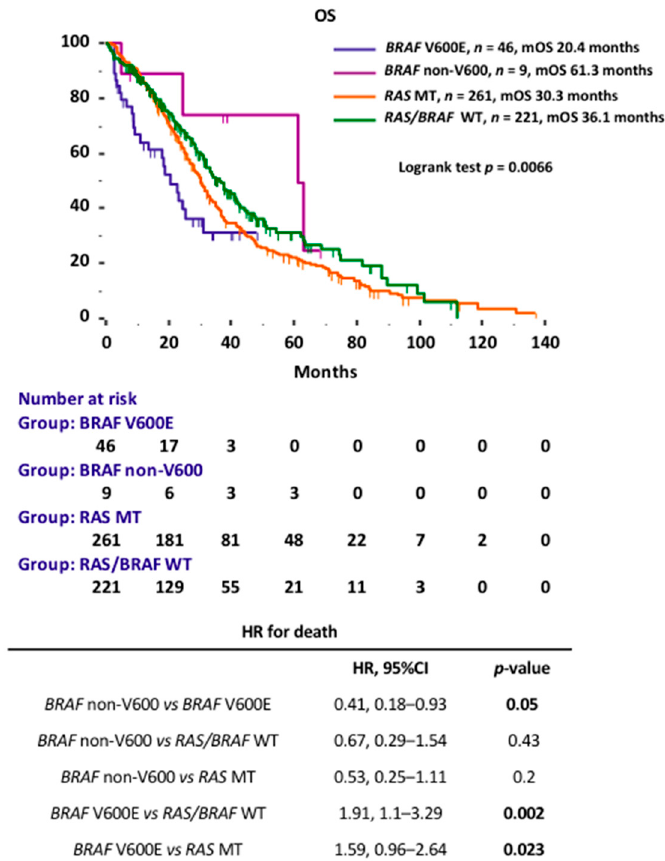
Figure 2. Kaplan–Meier OS curves according to RAS/BRAF mutational status. Table 3. Univariate and multivariate analysis for